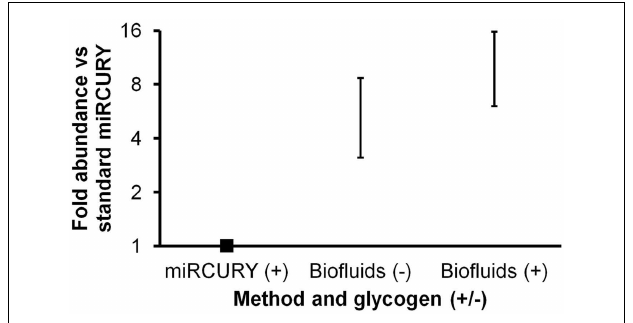
FIGURE 2 | Comparison of Exiqon miRCURY Cell and Plant and miRCURY Biofluids kits . Results of plasma miRNA RT-qPCR (technical triplicates) of duplicate isolations by the two Exiqon methods, with miRCURY Cell and Plant conducted with glycogen and Biofluids conducted both with and without glycogen. Fold abundance is relative to Exiqon miRCURY Cell and Plant. Bars represent range. Results of RT-qPCR for three endogenous and one spiked-in miRNA are shown. As noted in the text, the depicted differences versus Exiqon miRCURY Cell and Plant were significant.